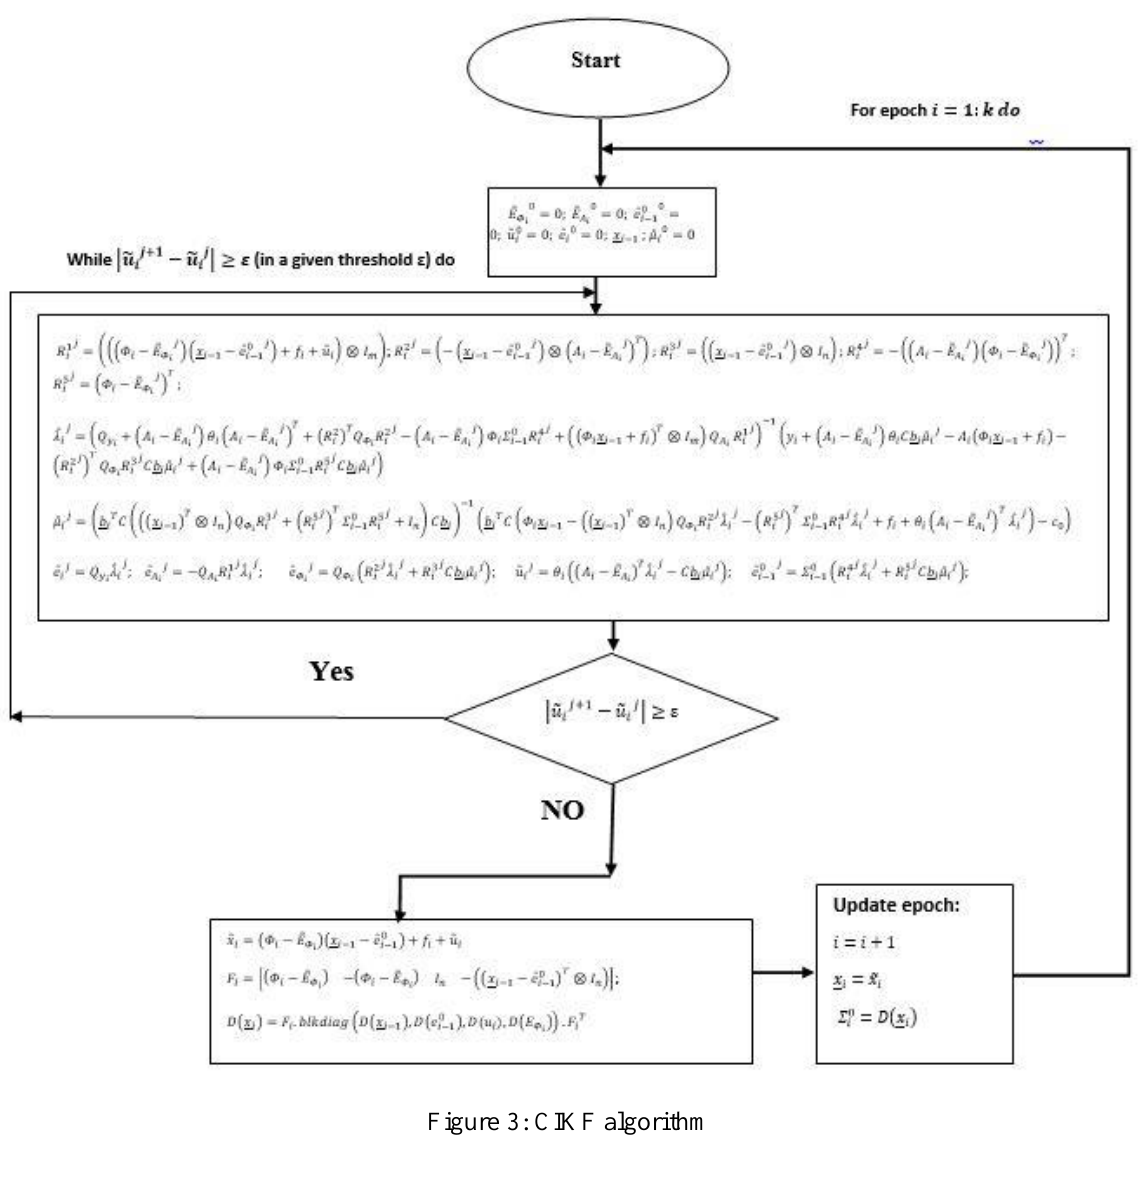
Section 3: numerical comparison of EKF algorithm with WTKF, IKF and CIKF